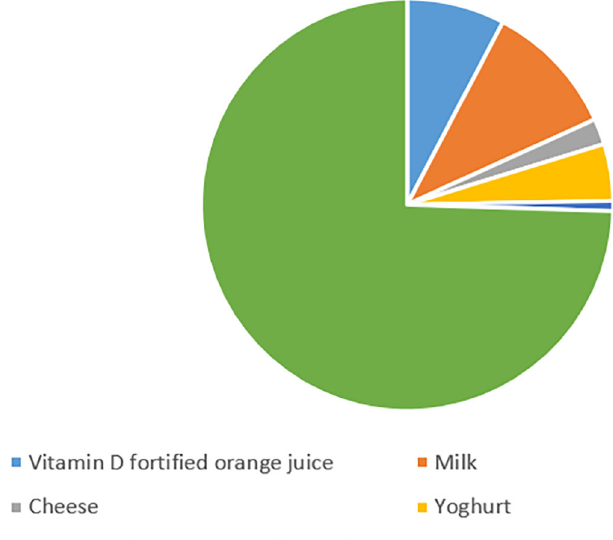
Figure 3. Children ’ s intake of natural sources containing vitamin D.